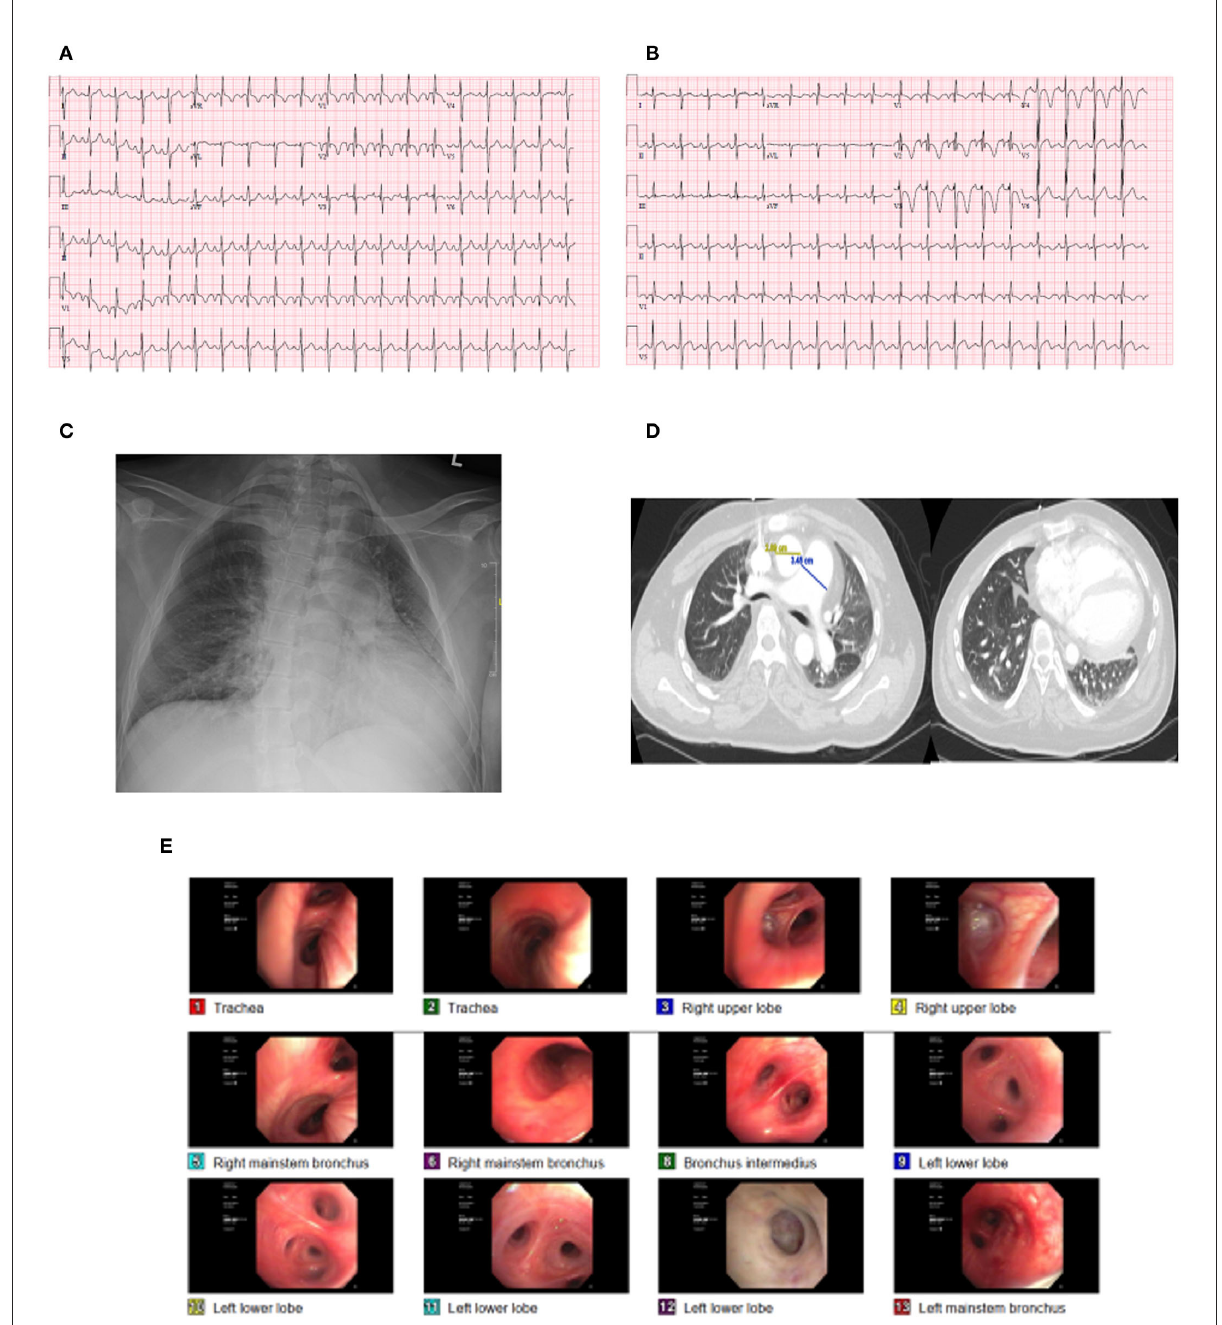
FIGURE1 Case illustration. (A) initial ECG showing sinus tachycardia and right bundle branch block. (B) repeat ECG showing ST depressions in V1 to V4. (C,D) CXR and CT of the chest showing pulmonary congestion and ground glass opacity. (E) Bronchospcopy.